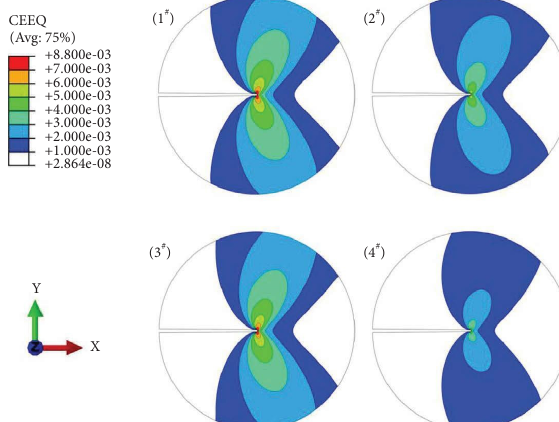
Figure 8: Equivalent creep strain (CEEQ) distribution of Ti-6Al-4V alloy in the crack tip region at diferent forging temperatures: (1 # ) 925 ° C, (2 # ) 975 ° C, (3 # ) 950 ° C, and (4 # ) 1000 ° C.